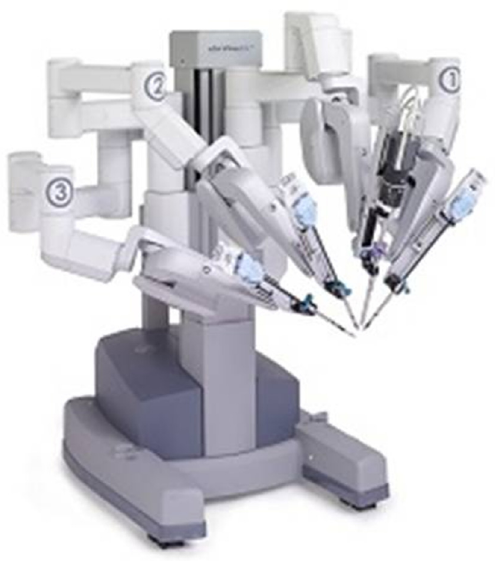
Figure 1. Da Vinci robot used in urological and general